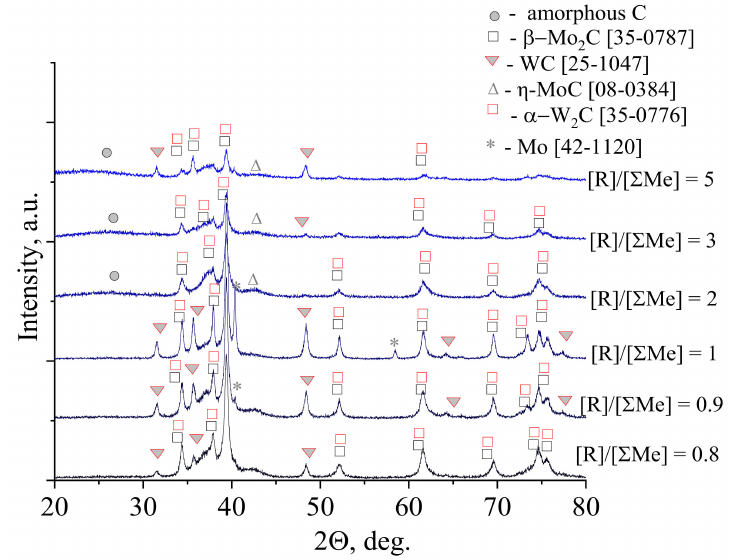
Figure 4. XRD pattern of molybdenum-tungsten carbides with molar ratio [Mo] / [W] = 50 / 50 calcined at 900 ◦ C in inert